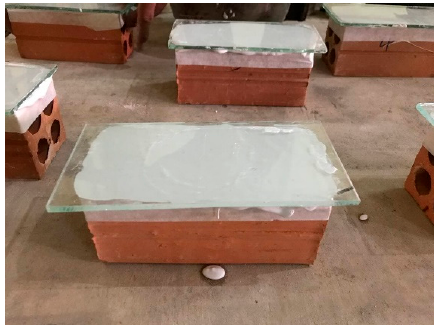
Figure 4. Capping of bricks.